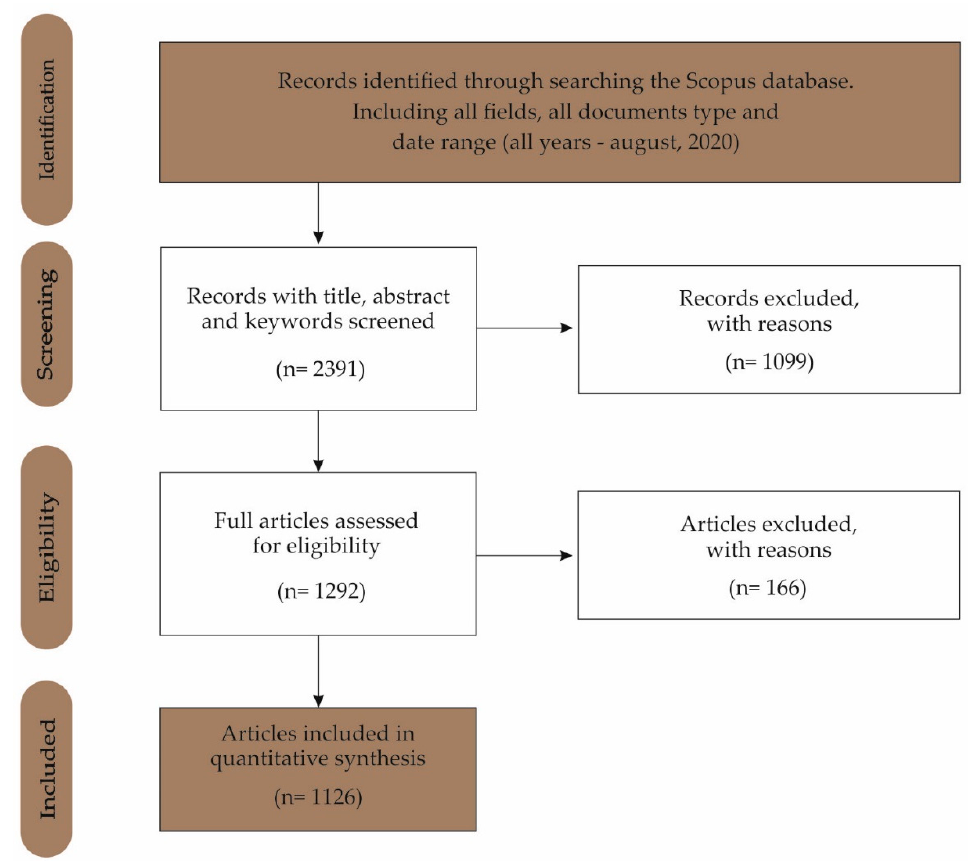
Figure 1. Flowchart based on preferred reporting items for systematic reviews and meta-analyses (PRISMA).